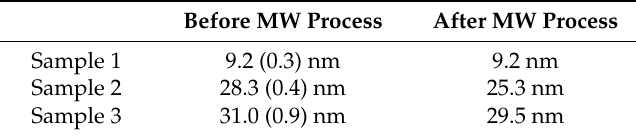
Table 3. Crystallite diameter of pristine TiO 2 and synthesized Ti 4 O 7 by microwave; MW: microwave